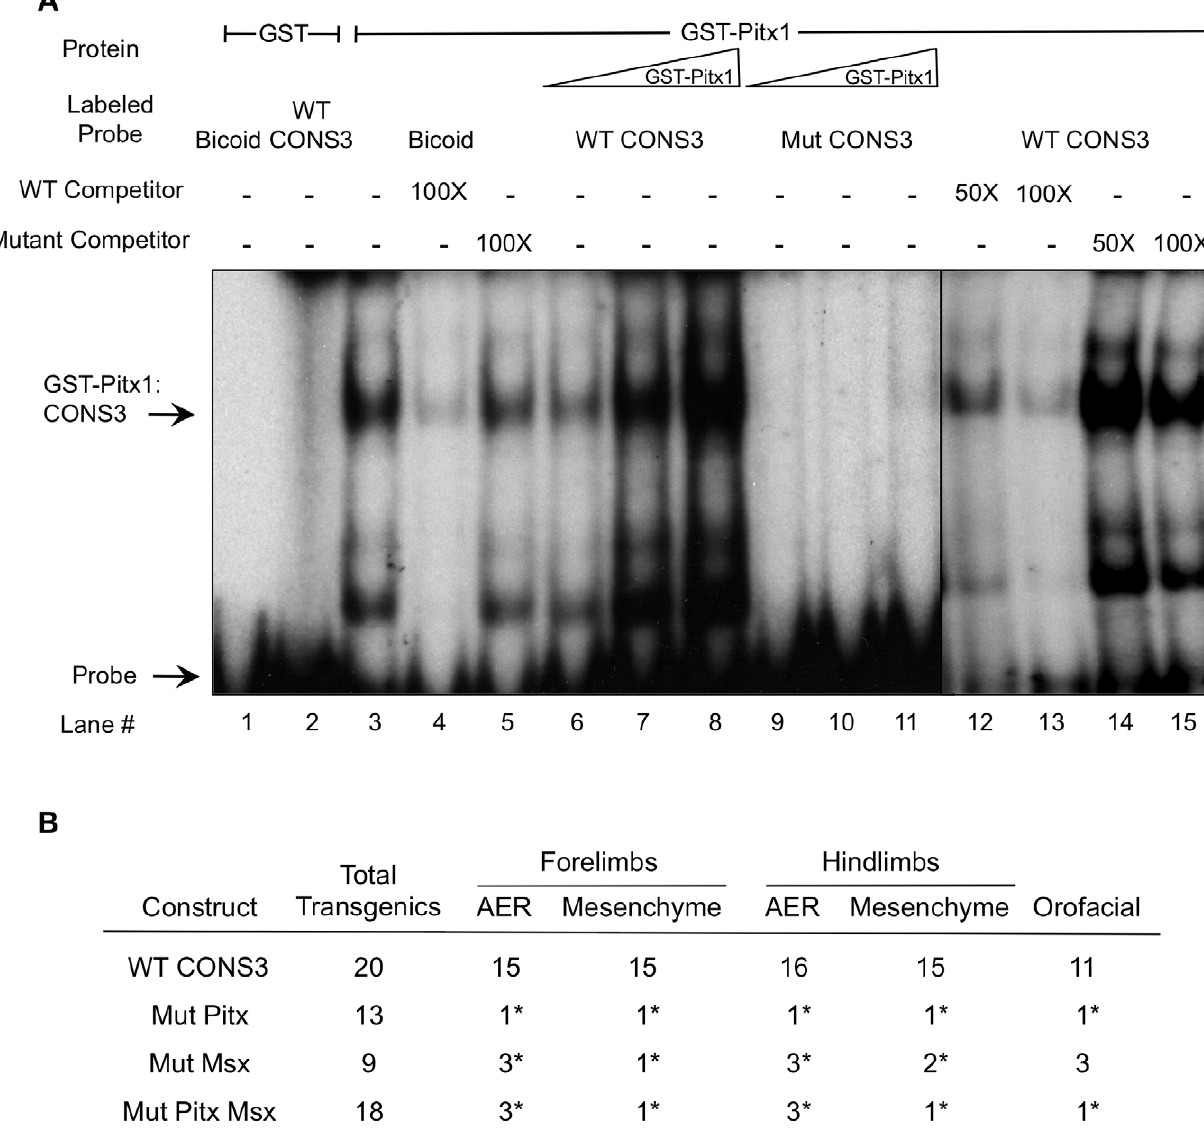
Figure 5. Pitx binds to the minimal Bmp4 enhancer CRM invitro and the Pitx binding site is necessary for enhancer activity. ( A ) Electrophoretic Mobility Shift Assay (EMSA) exhibits robust binding of Pitx1 protein to both a positive control bicoid DNA sequence and to the consensus Pitx1/2 binding site in with a 25 bp probe sequence in the CONS3.8 sequence. Competition with specific or non-specific unlabelled probes indicates sequence-specific binding of GST:Pitx1 fusion protein to the consensus Pitx1/2 DNA binding motif. ( B ) Number of transient transgenic embryos that supported b -galactosidase expression in forelimbs, hindlimbs, or orofacial tissue. Asterisk indicates statistically significant differences (p , 0.05) compared to wild-type CONS3 by Fisher’s exact